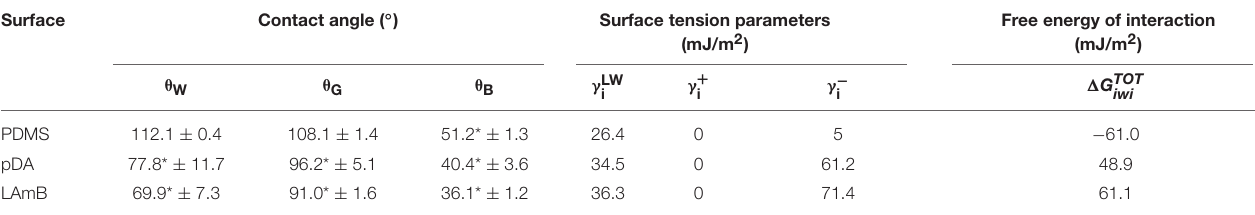
TABLE 3 | Values of contact angles ( ◦ ) with water ( θ W ), glycerol ( θ G ), α -bromonaphtalene ( θ B ), surface tension parameters (mJ/m 2 ), and free energy of interaction ( 1 G TOT iwi ) (mJ/m 2 ) between the surfaces (i) when immersed in water (w).